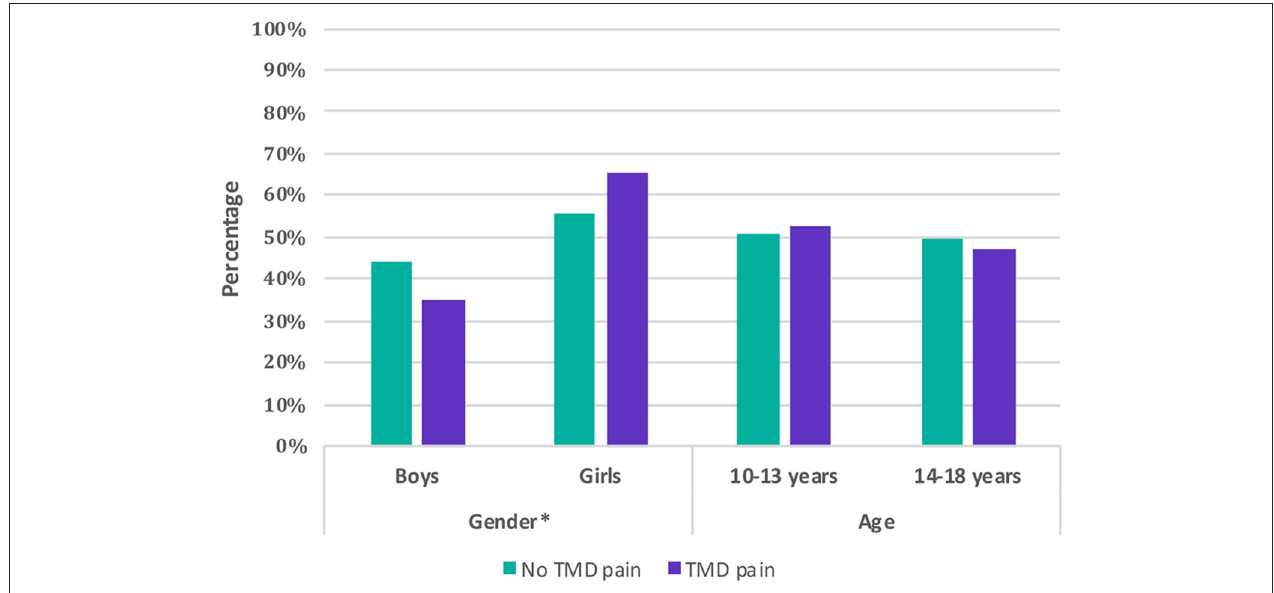
FIGURE 3 | Comparison of children and adolescents with and without self-reported painful temporomandibular disorders (TMD-P) by gender and